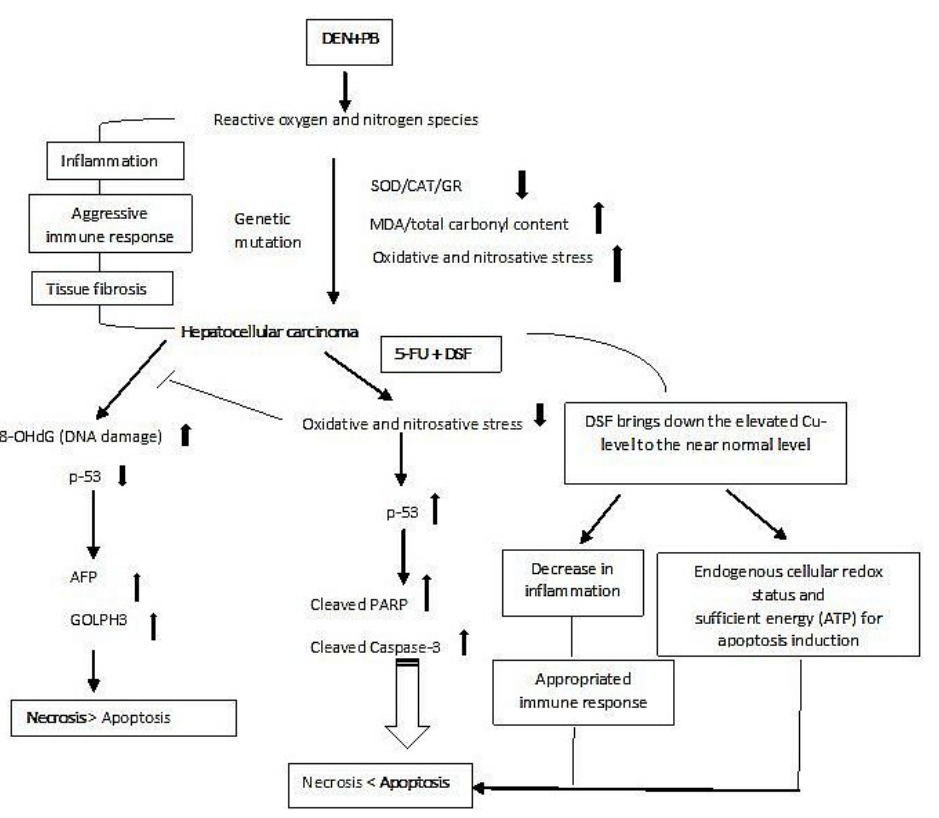
Figure 9. Putative mechanism of the enhanced anticancer capability of 5-FU in the presence of DSF in DEN-PB-induced hepatocarcinoma in rats. 2. Materials and Methods.